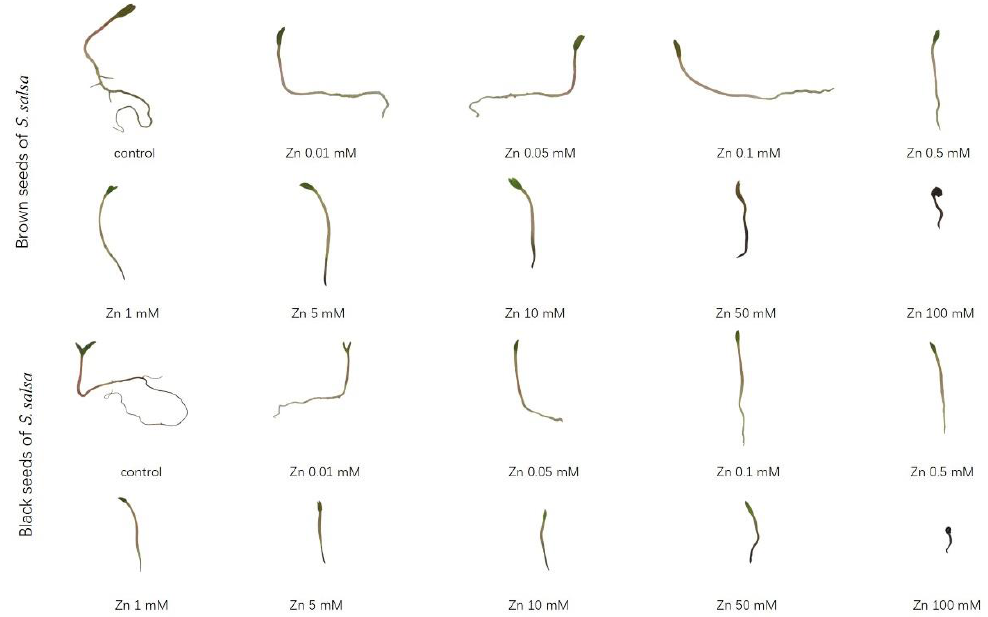
Figure 4. Radicle elongation of seedlings grown from dimorphic seeds of S. salsa after 20 days in various concentrations of Zn solutions.